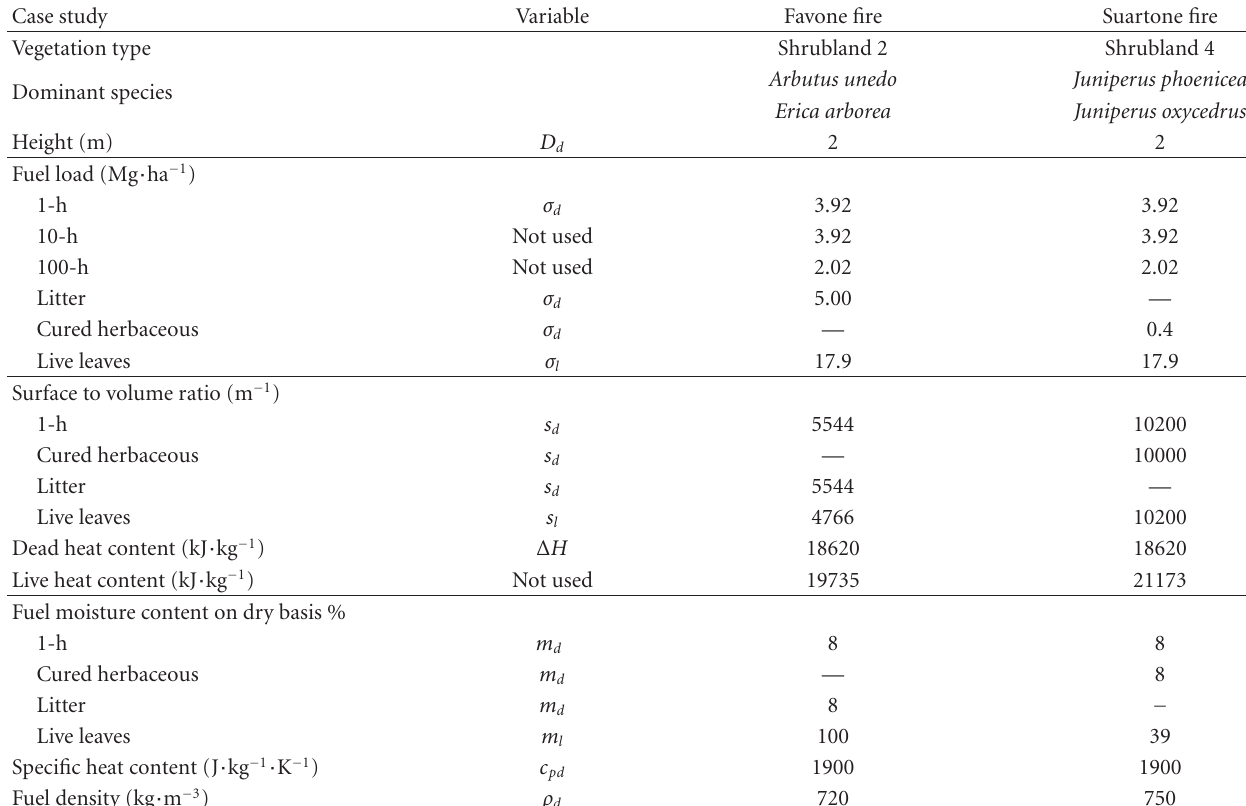
Table 2: Fuel parameters for Favone and Suartone fire case